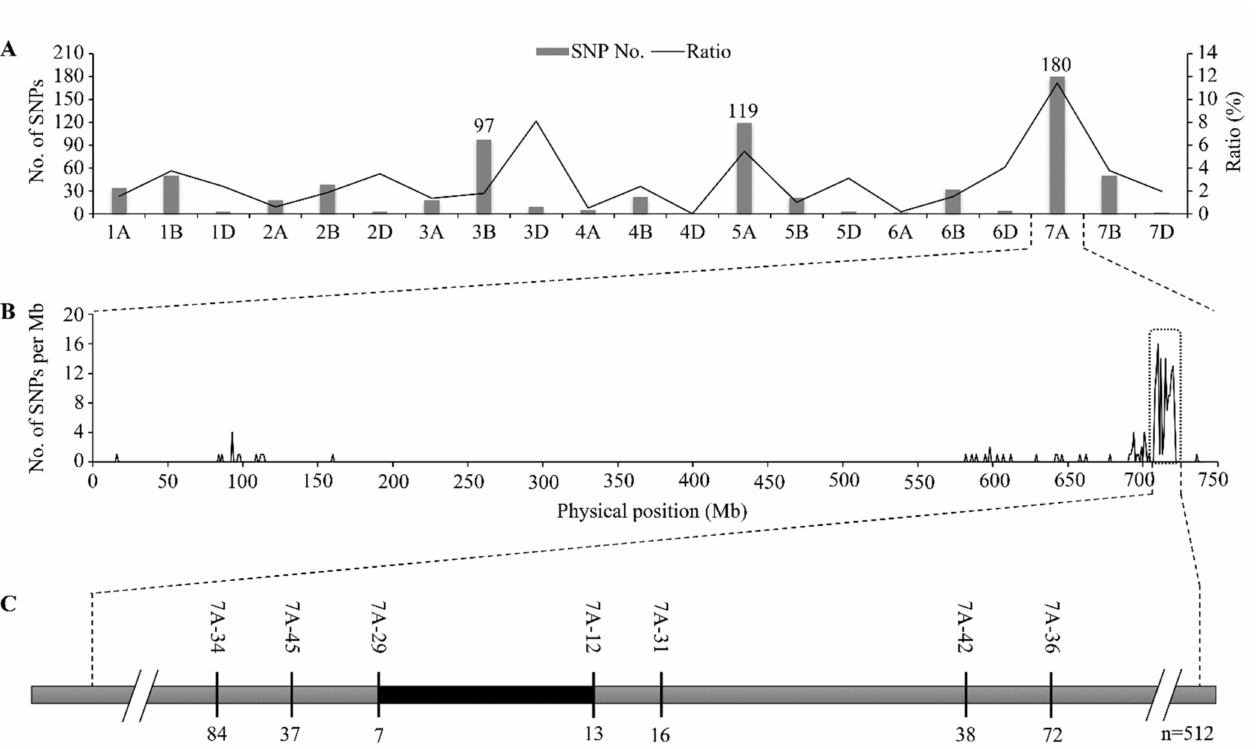
Figure 4. Mapping of locus controlling wheat leaf rolling degree. ( A ) The number and percentage of polymorphic SNP loci in each of the 21 wheat chromosomes. ( B ) The number of SNPs in each 1 Mb region of chromosome 7A identified using the Wheat 660K SNP array. ( C ) LERD1 was mapped to a 2.36 Mb region between markers 7A-29 and 7A-12. The black rectangle represents the final target region harboring LERD1 . The numbers below the bar indicate the number of recombinants between LERD1 and the molecular